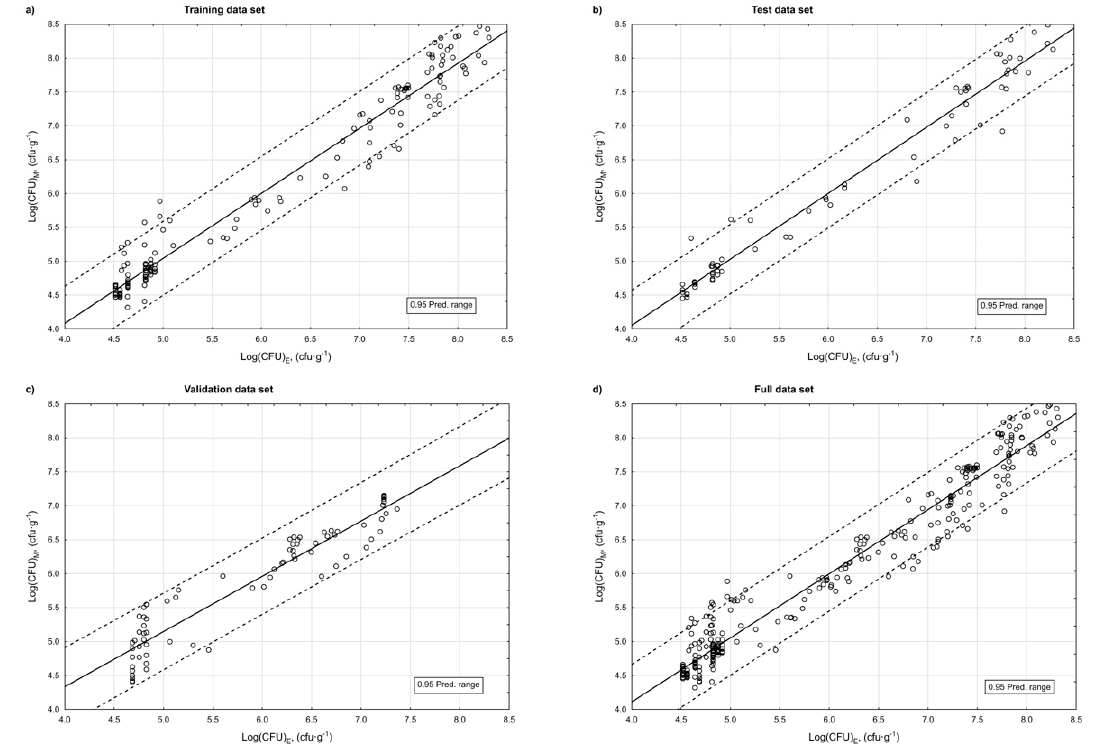
Figure 8. Levels of mold contamination in rapeseed ecosystems with water activity a w = 0.75–0.90 Figure 8 stored at 12–30 ◦ C predicted by the RBF neural network model (Log(CFU) M against experimental levels of the fungal population (Log(CFU) E ) adopted from Wawrzyniak et al. [6] for ( a ) training, ( b ) test, ( c ) validation, and ( d ) full data